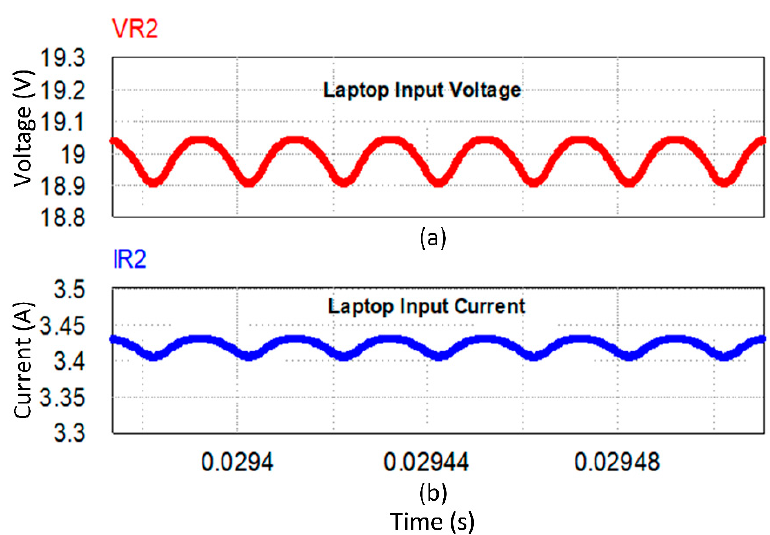
Figure 8. Laptop Input Voltage and Current Waveform. Laptop Input Voltage Ripple: 0.7%; Current Ripple: 0.58%. ( a ) Laptop input voltage; ( b ) Laptop input current.